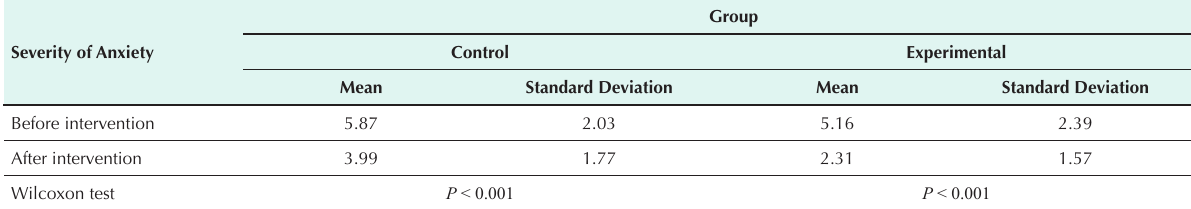
Table 4. Numerical Index of Patients’ Anxiety Changes in Experimental and Control Groups and the Comparison of the Averages in 2017 Anxiety Changes